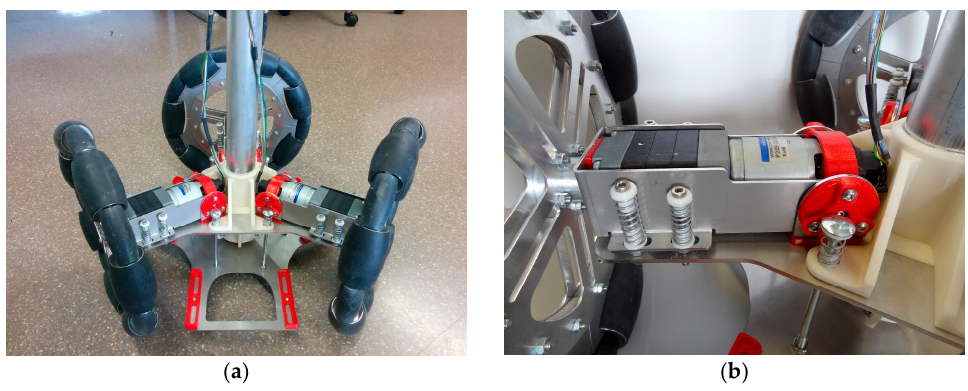
Figure 5. Image of the passive suspension system of the APR-2; ( a ) overview, ( b ) arm detail.